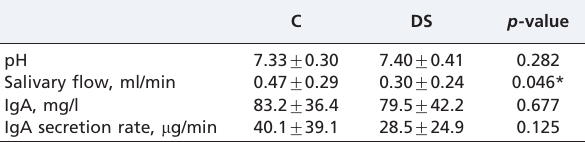
Table 4 - The salivary pH, flow, and IgA concentration of Down syndrome (DS) children and sibling controls